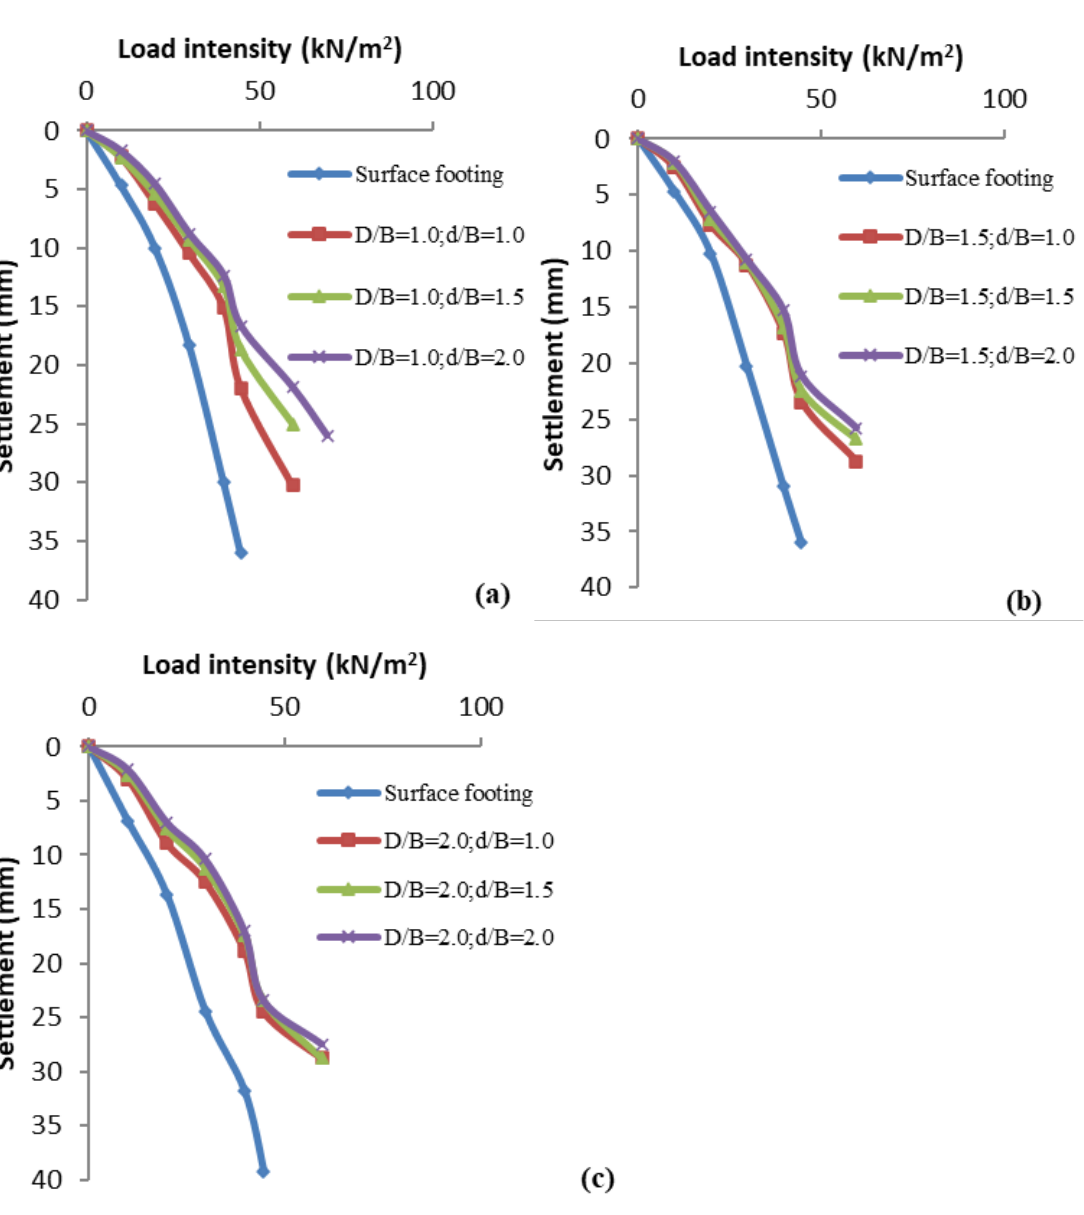
Figure 6: Load intensity- settlement behavior of footing with confiner at 5° angle of inclination for (a) D/B=1.0 (b) D/B=1.5 (c) D/B=2.0 with variation of d/B=1.0,1.5,2.0